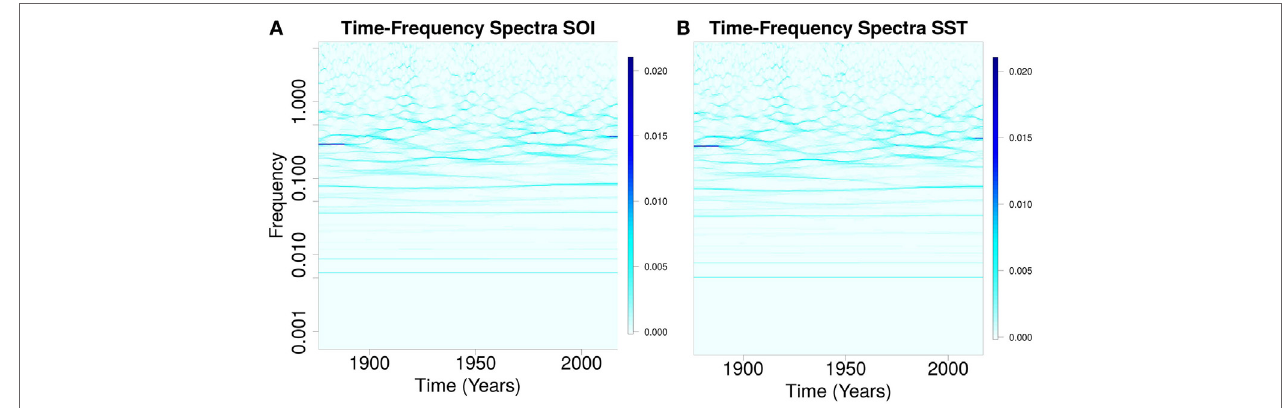
FigUre 1 | Spectra of southern oscillation (SOI) and sea surface temperature (SST). (a) (SOI) and (B) (SST) show similar oscillations with timescales from sub-annual to